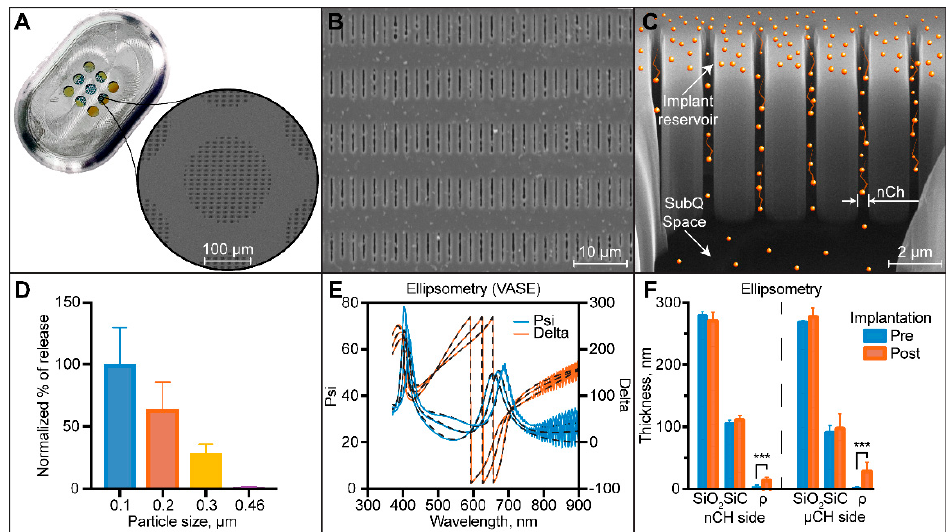
Figure 1. The nanofluidic implant for subcutaneous tenofovir alafenamide (TAF) HIV-1 treatment delivery (nTAF t ). ( A ) Top-view image of the assembled nTAF t with a zoom-in on the nanofluidic membrane demonstrating an SEM of the nanochannels. ( B ) Higher magnification of a top-view of SEM image of nanochannel membrane. ( C ) FIB image of nanochannel membrane cross-section showing drug release through vertically etched nanochannels. ( D ) Latex bead filtration through nanochannel. ( E ) Ellipsometry analysis of membrane surface. ( F ) Ellipsometry analysis of membrane